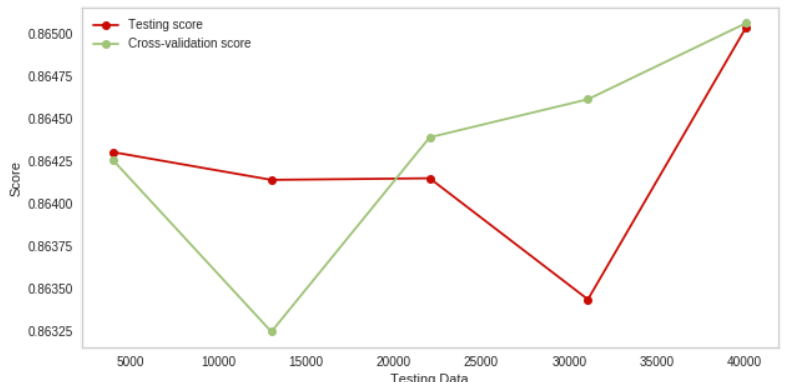
Figure 20. Binary Class naive Bayes testing and validation learning curve.